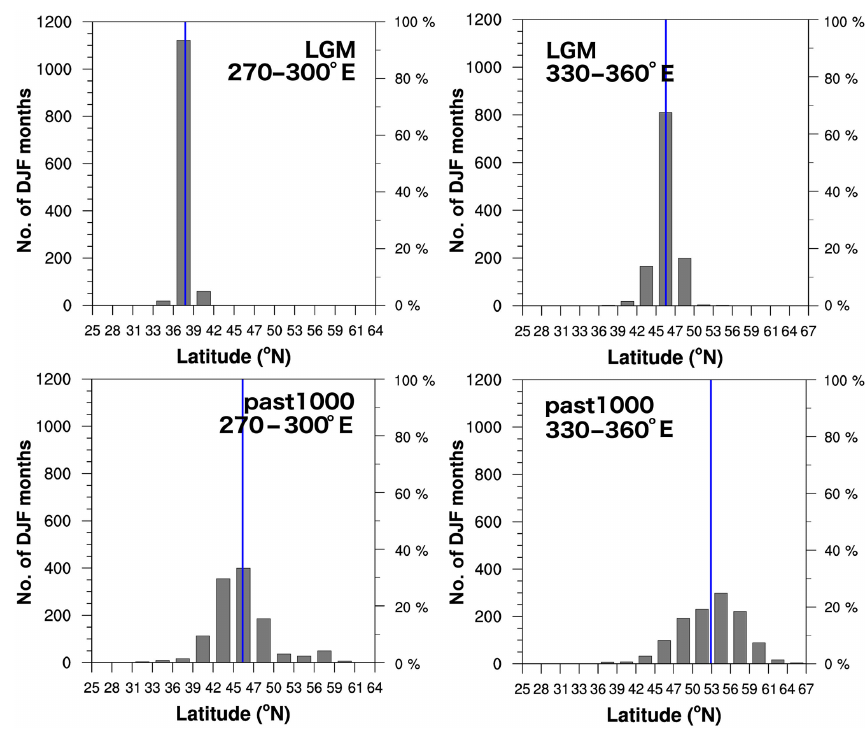
Figure 7. Histograms of latitudes corresponding to peak NAtl zonal winds for all PlaSim ensemble members over the western and eastern regions of the jet during indicated periods. Vertical blue lines indicate mean jet latitudes for the time